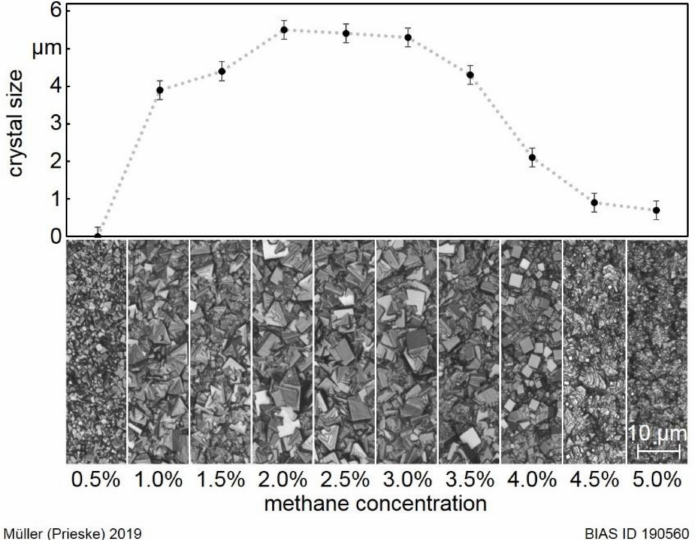
Figure 5. Crystal size as a function of the methane concentration for the deposition temperature of 1050 ◦ C and the coating time of 20